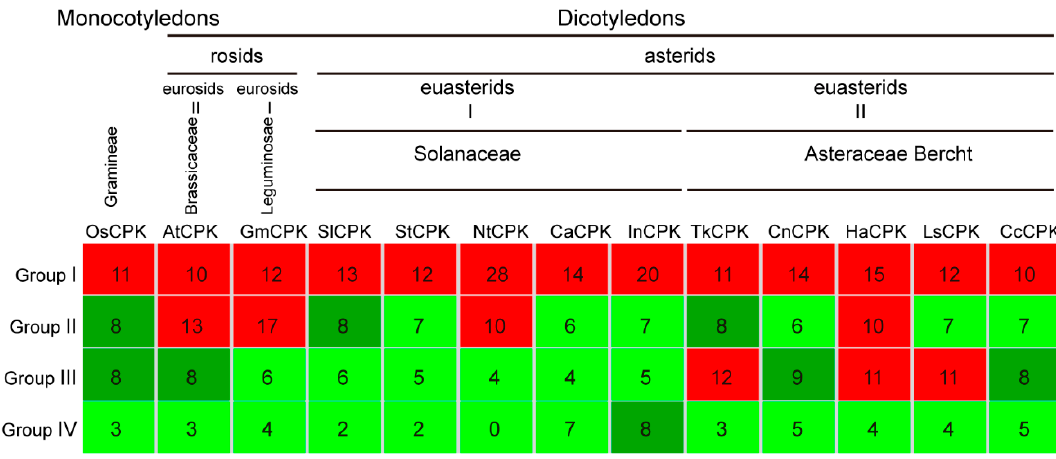
Figure 4. Expansion of CPKs in different groups. Thirteen species are ordered by plant classification system. The number of CPKs of four distinct groups from different species are indicated in the colored boxes. Red and green represent a large or a small number of CPK members, respectively.